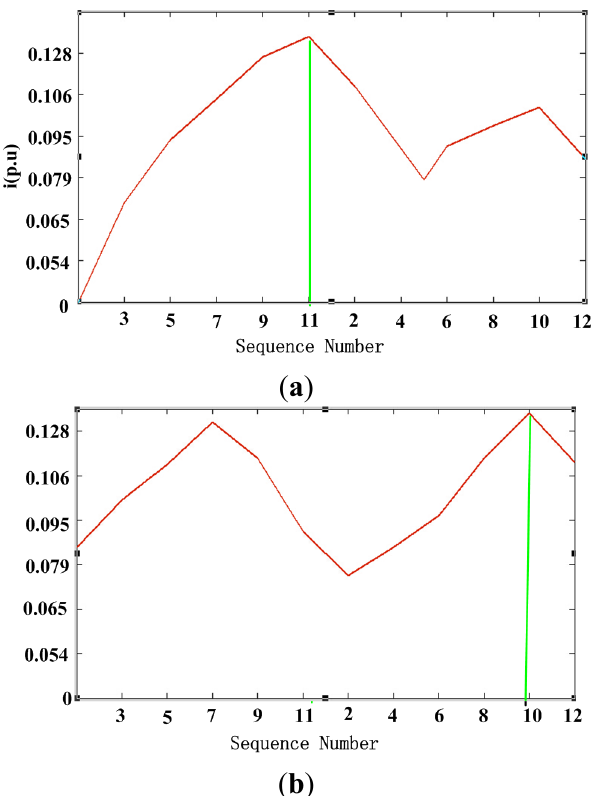
Figure 12. Current amplitude of the first series voltages. ( a ) 0.15 times the reference value; and ( b ) 0.4 times the reference value.